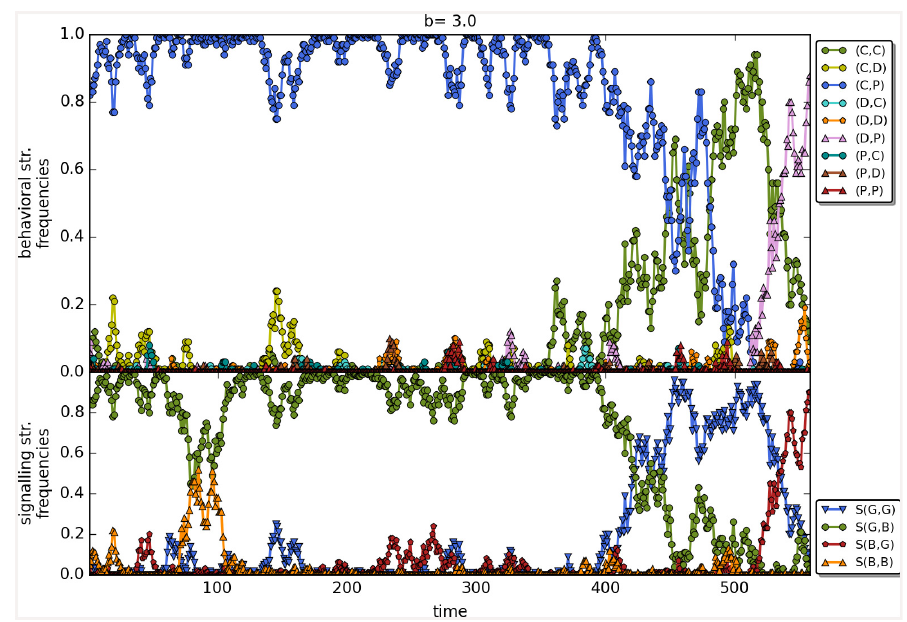
Fig 12. The timeline of an individual run using the social norm scoring. The figure shows the change in the frequencies of the behavioural and signalling strategies as a function of time for the social norms scoring. Numbers on the x axis denote 100 steps. Parameters: n = 100, b = 3.25, c = 1, α = 1, β = 4, MST = 80%.